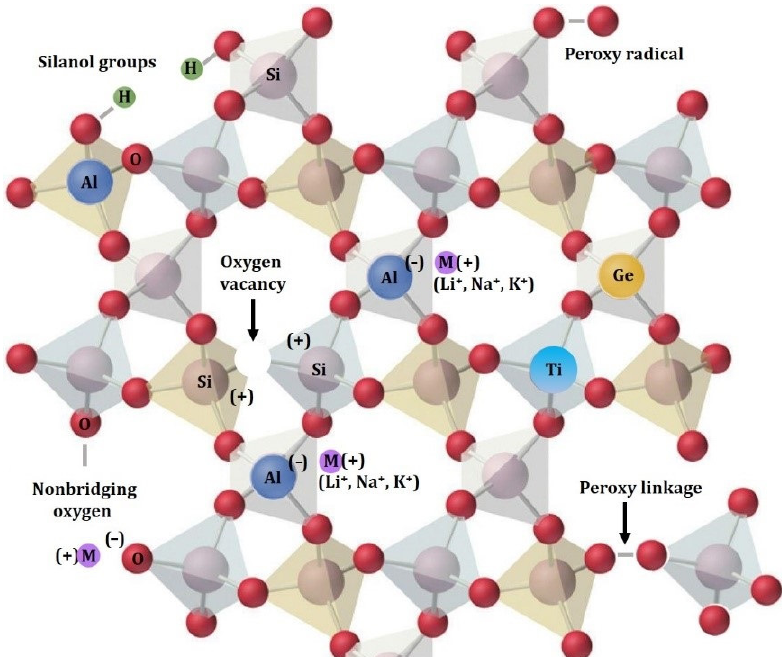
Figure 2. Crystal structure of quartz showing possible defects and impurities. In the scheme are reported: oxygen vacancy, silanol groups (possible substitution of Si 4+ by four H + ), nonbridging oxygen, peroxy linkage and radicals, simple substitutions with Ti 4+ and Ge 4+ , Al 3+ substitutions with interstitial cations (Li + , Na + , K + ) [28,30].